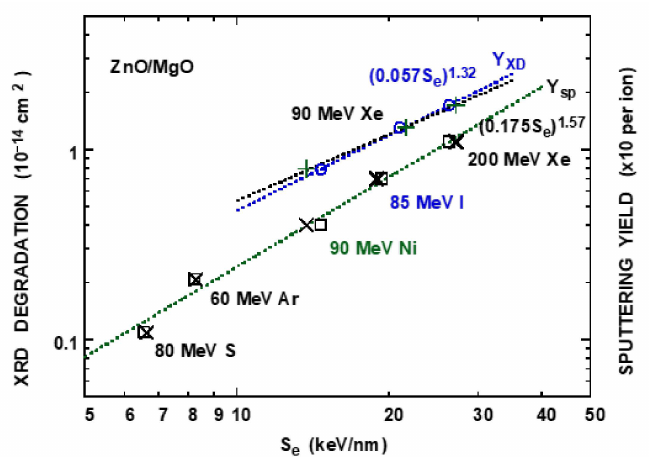
Figure 4. XRD degradation per unit fluence Y XD of polycrystalline ZnO film vs. electronic stopping power S e (TRIM1997 and SR2013). Power-law fit to Y XD = (0.057S e ) 1.32 (TRIM1997) (o, blue dotted line) and (0.0585 S e ) 1.16 (SRIM2013) (+, black dotted line). Sputtering yield Ysp vs. S e (TRIM1997, (cid:3) ) and S e (SR2013, x) is also shown. Sputtering yield from [54]. Power-law fits to Ysp: (0.175 S e ) 1.57 for both S e from TRIM1997 and SR2013 is indicated by green dotted